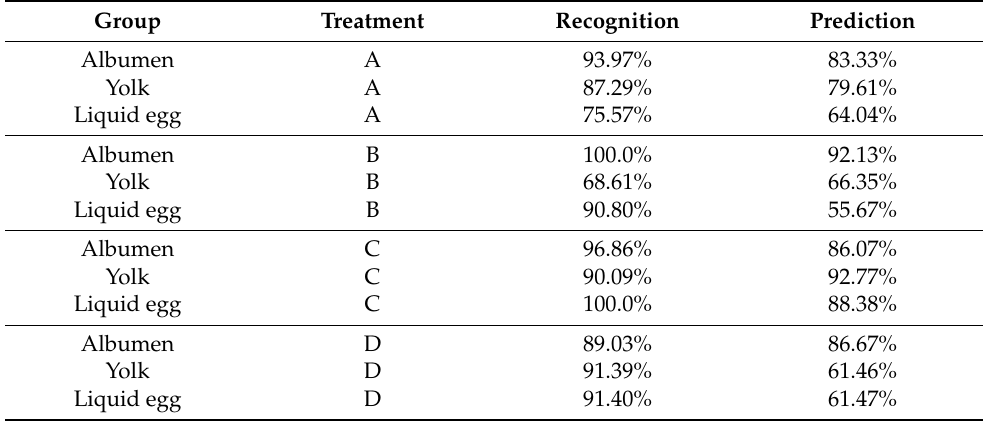
Table 3. The accuracy of the observed models.